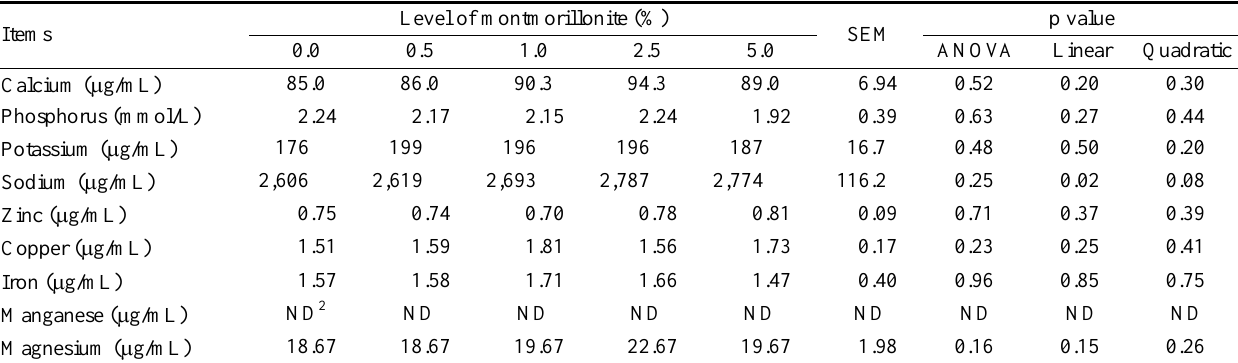
Table 5. Serum mineral element concentrations of weaned pigs fed diets containing graded levels of montmorillonite (d 28) 1